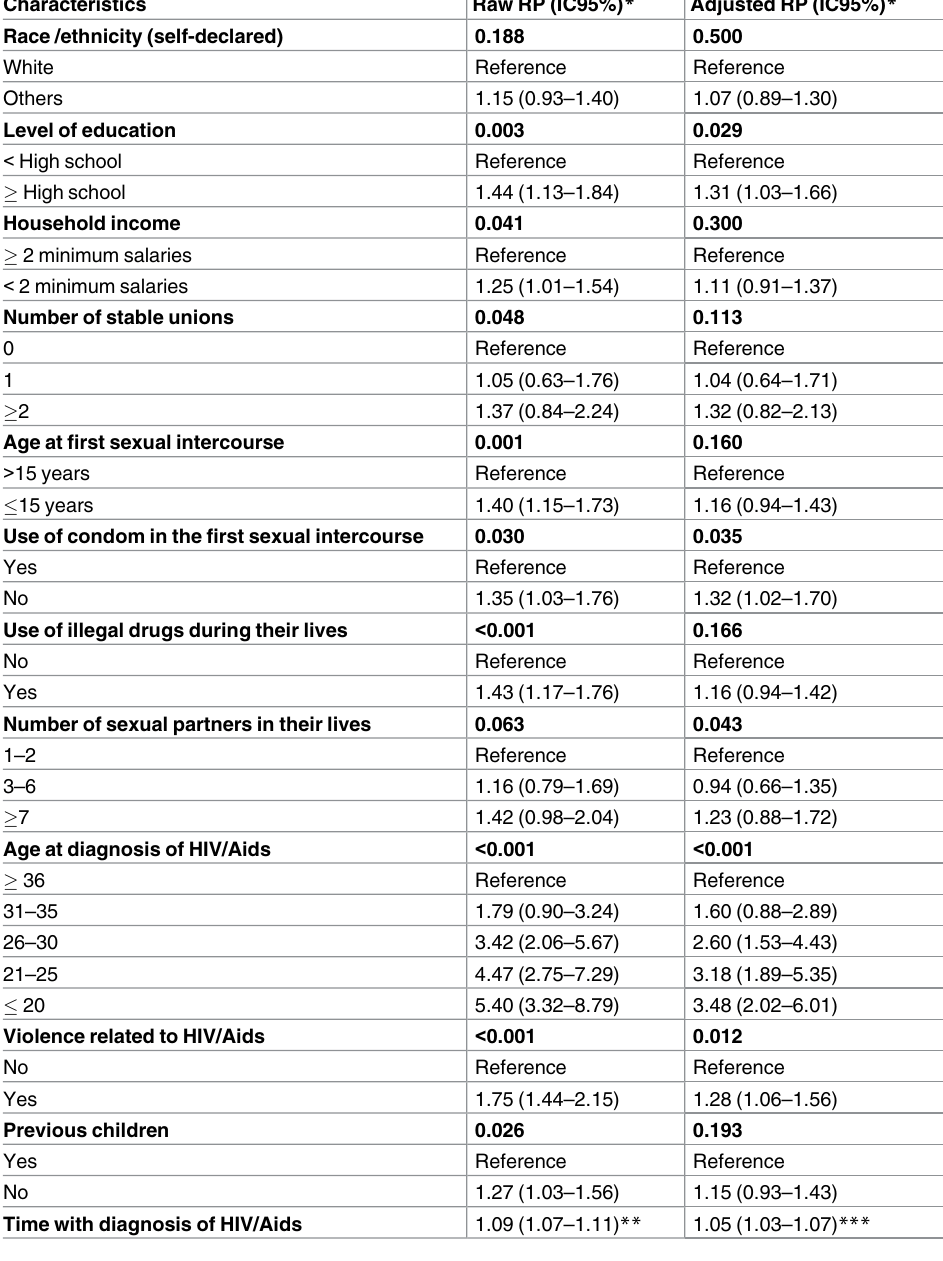
Table 3. Association between the occurrence of pregnancies after the diagnosis of HIV/Aids and the studied characteristics, Porto Alegre,